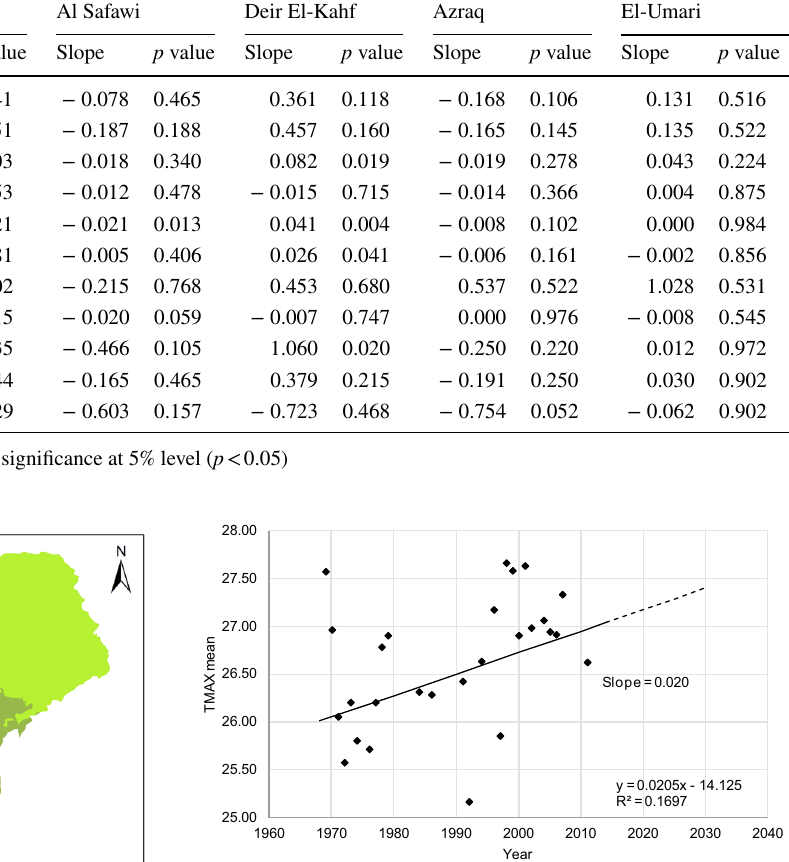
Table 5 Annual linear trends of the extreme climate indices for precipitation over the study area